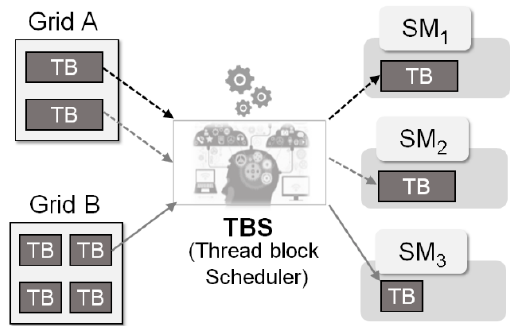
Figure 2. An example of Thread Block Scheduling (TBS) that allocates Thread Blocks (TB) to Stream Multiprocessors (SM).